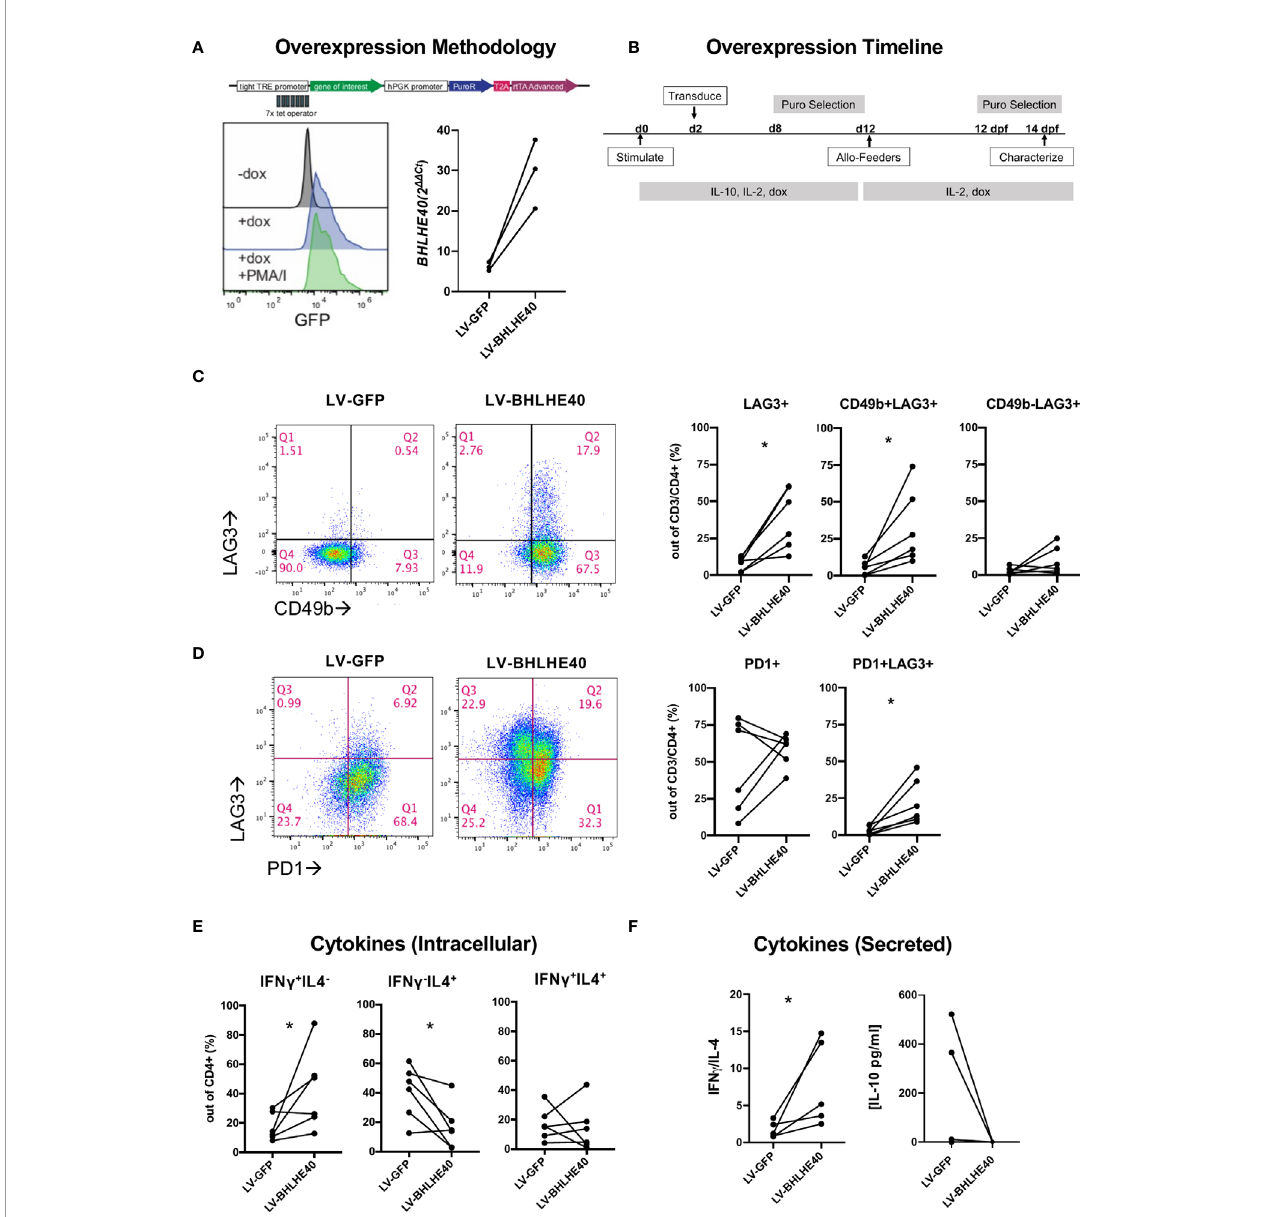
FIGURE 2 | Overexpression of BHLHE40 induces co-expression of CD49b and LAG3 in naïve CD4 + T cells. (A) Validation of a dox inducible system for transgene overexpression in CD4 + T cells. pCW57.1 construct used for expressing GFP or BHLHE40 (top). GFP expression in CD4 + T cells is induced after addition of dox. Transgene expression is maintained during activation. Dox was incubated for 4 hours and cells were immediately collected and checked for GFP expression by fl ow cytometry (Bottom-left). BHLHE40 overexpression con fi rmed by qPCR. GFP and BHLHE40 transduced CD4 + T cells were incubated with dox for 4 hours and RNA was collected. BHLHE40 RNA was measured using qPCR Taqman probes along with housekeeping genes : RPLPO, GAPDH . n = 3 (Bottom-right). (B) Timeline of dox-inducible BHLHE40 in naïve CD4 + T cells. CD4 + naïve T cells were cultured with IL-10 and then expanded on allo-feeders with IL-2 for 14 days before being characterized. (C, D) Surface phenotype of transduced cells after 2 rounds of allo-feeder expansion. Gated on live, CD3 + , CD4 + cells (C) CD49b and LAG3 expression. Representative plots of CD49b and LAG3 in one donor (Left). Summarized data of CD49b and LAG3 expression on BHLHE40 overexpressing cells compared to GFP expressing cells. (Right). n = 6. (D) Co-expression of LAG3 and PD1. Representative plots of PD1 and LAG3 in one donor (Left). Summarized data of PD1 and LAG3 expression on BHLHE40 overexpressing cells compared to GFP expressing cells (Right). n = 6. (E, F) Increased Th1 phenotypic cytokines in BHLHE40 overexpressing cells. (E) Increased intracellular IFN- g + /IL4 - cells in BHLHE40 overexpressing cells. Intracellular cytokine staining of IFN- g and IL-4 in BHLHE40 overexpressing cells after 5 hours of PMA/I and Brefeldin A n = 6. Ratio paired t-test. (F) Increased secretion of IFN- g . Cells are stimulated for 48 hours with plate-bound a CD3 and soluble a CD28.Cytokines in the supernatant were quanti fi ed by ELISA. IFN g /IL-4 ratios (Left). Absolute IL-10 concentrations (Right). n = 5, Ratio paired t test. PMA/I, phorbol-myristate-acetate/ionomycin, Allo-feeders = allogenic-PBMC feeders; Dox, doxycycline; dpf, days post feeder; puro, puromycin. *p value <